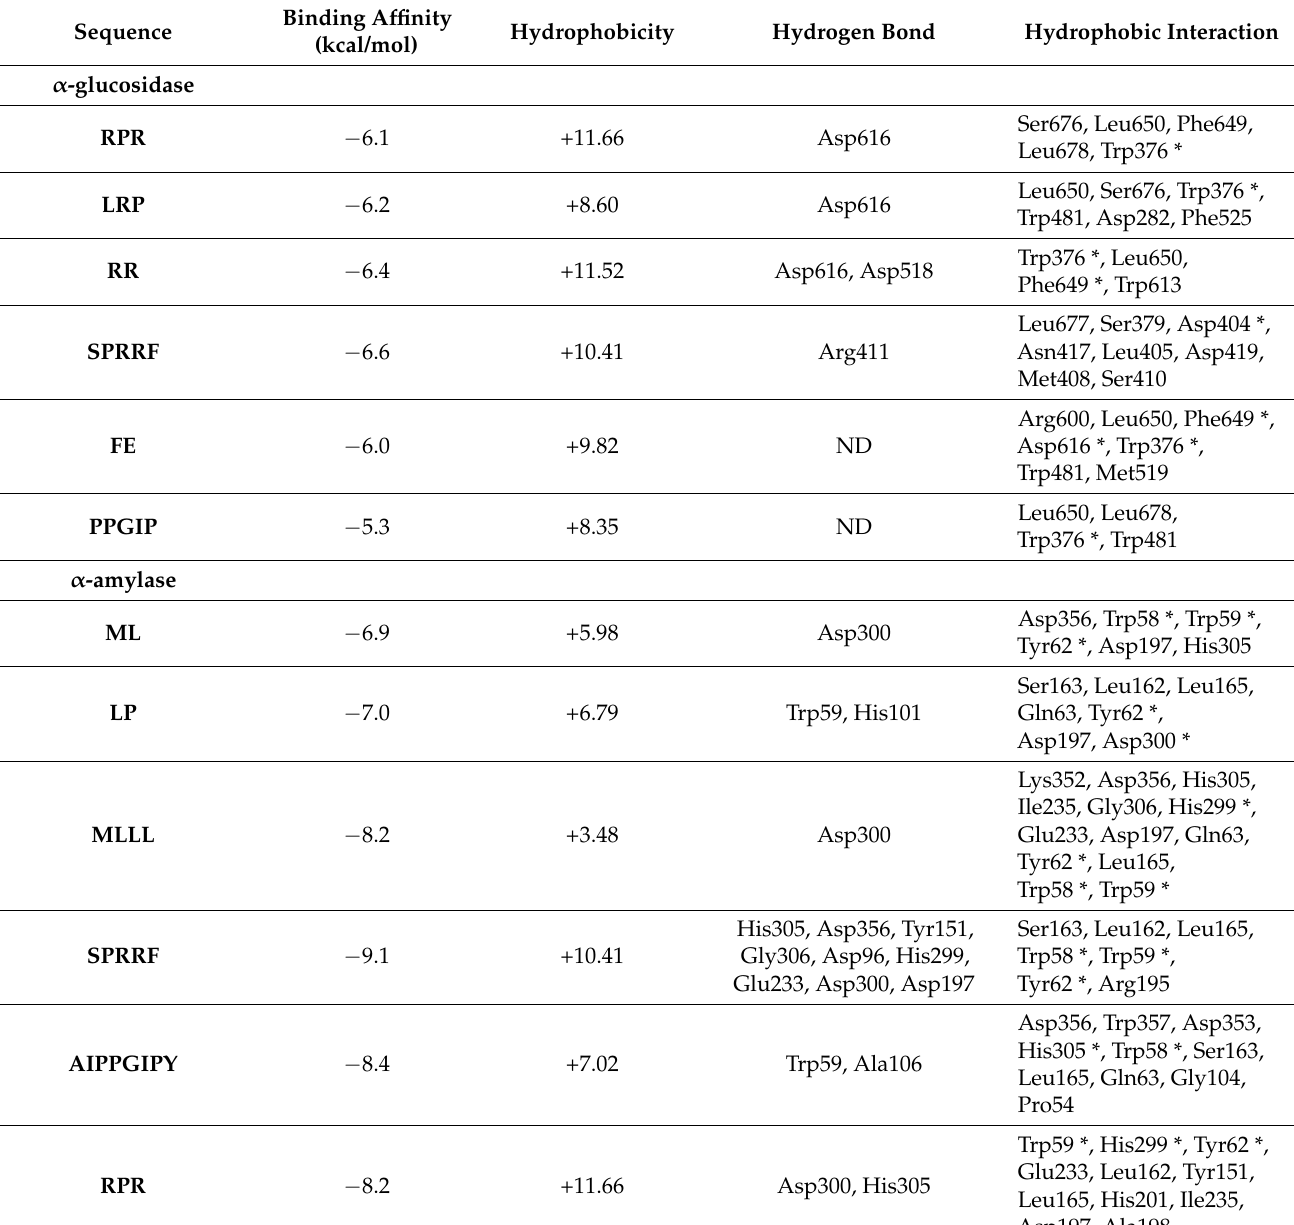
Table 6. Binding affinity and some physicochemical properties of the selected α -glucosidase and α -amylase inhibitors from ACT and FCT